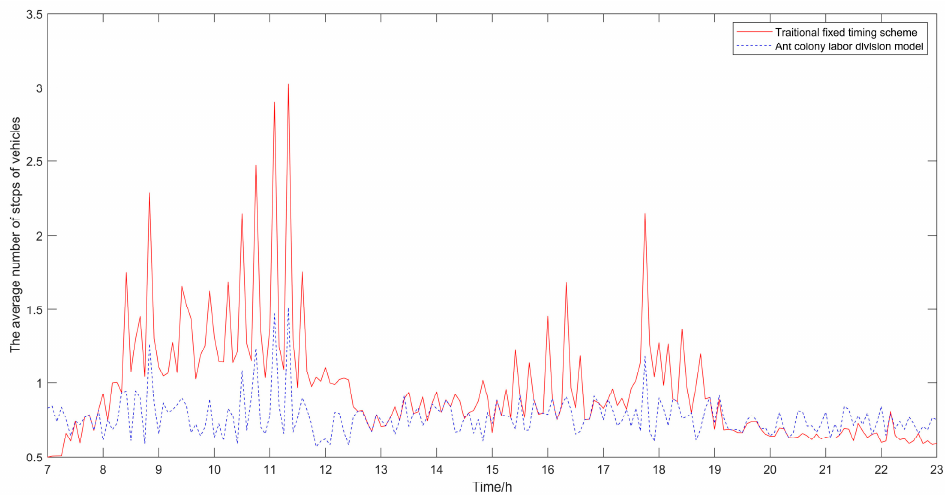
Figure 6. Comparison diagram of the average number of stops of vehicles.